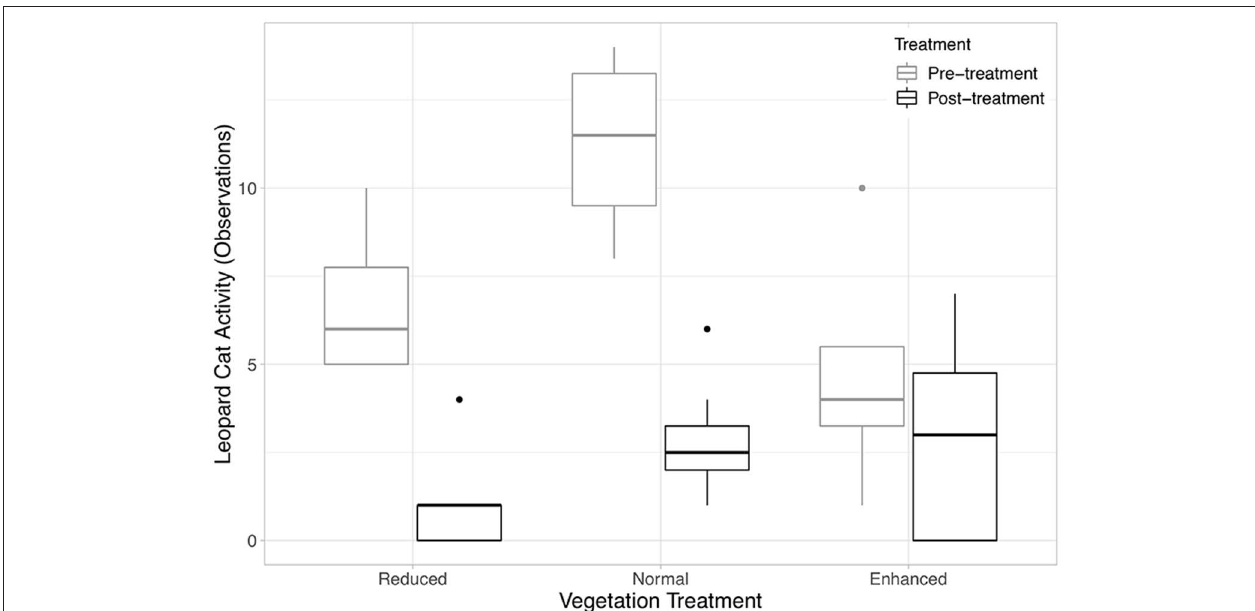
FIGURE 2 | Boxplots showing the median and interquartile ranges (IQR) of Leopard Cat activity (number of observations) against vegetation treatment (Equation 1 in Supplementary Information , Equation 1 in Table 1 ). The legend codes the time period. Post-treatment data includes 2 and 3 years after the treatment was applied. The whiskers incorporate data that are 1.5*IQR. Data beyond the whiskers are plotted individually.